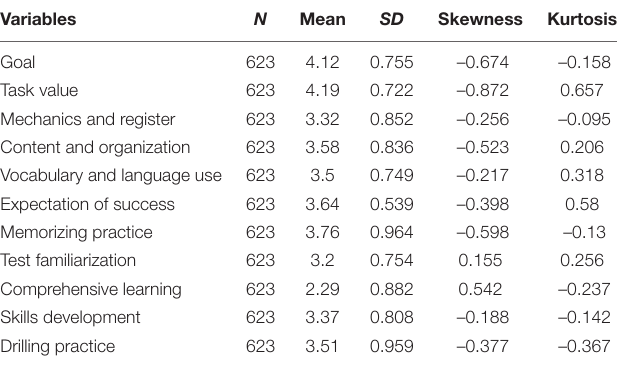
TABLE 2 | Descriptive statistics for observed variables in structural models.